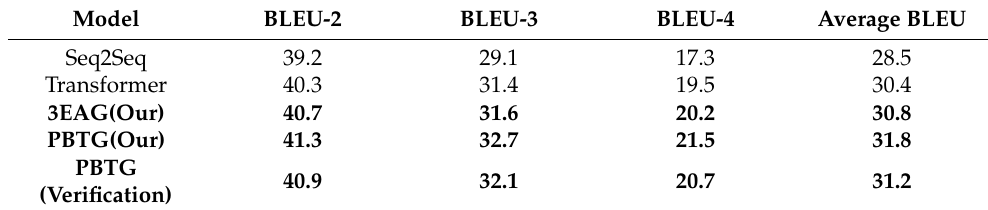
Table 4. BLUE’s evaluation results of open-domain dialogue.